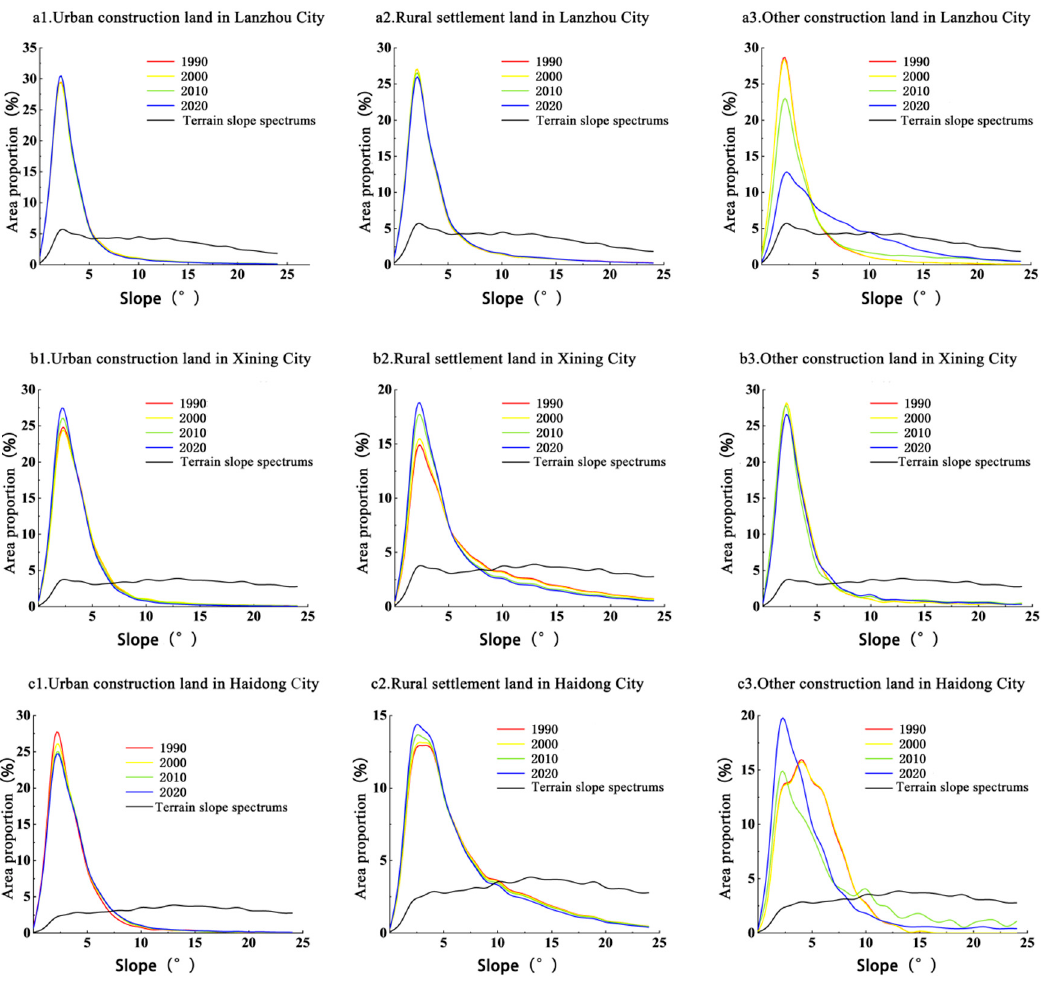
Figure 13. Terrain and built-up land slope spectra of typical cities in the LXUA from 1990 to 2020.